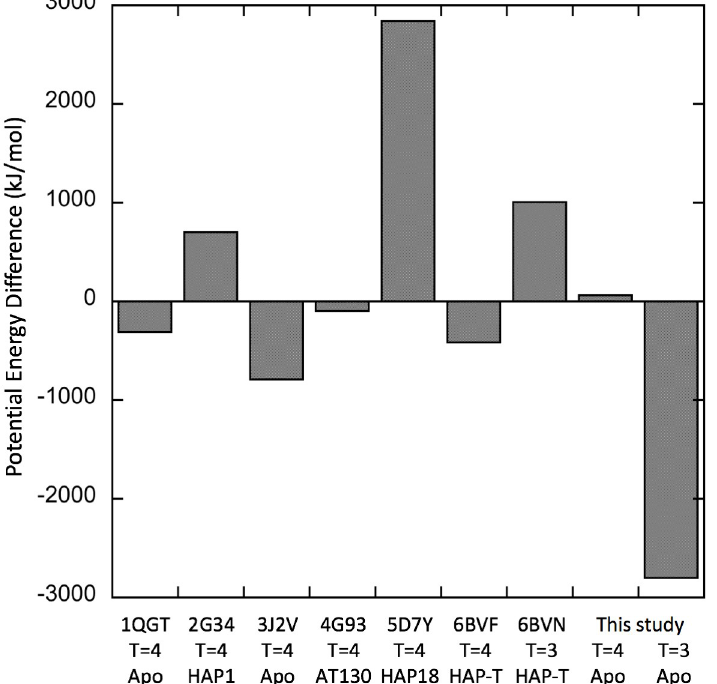
Fig 6. Potential energy difference between AB and CC dimers in T = 3 capsids, and between AB and CD dimers in T = 4 capsids. The subtraction is CC-AB for T = 3 dimers, and CD-AB for T = 4 dimers. The C chain containing dimers CC and CD have a lower potential energy than their corresponding AB dimers, and the T = 3 CC dimer has a particularly low potential energy. Ligands can disturb these